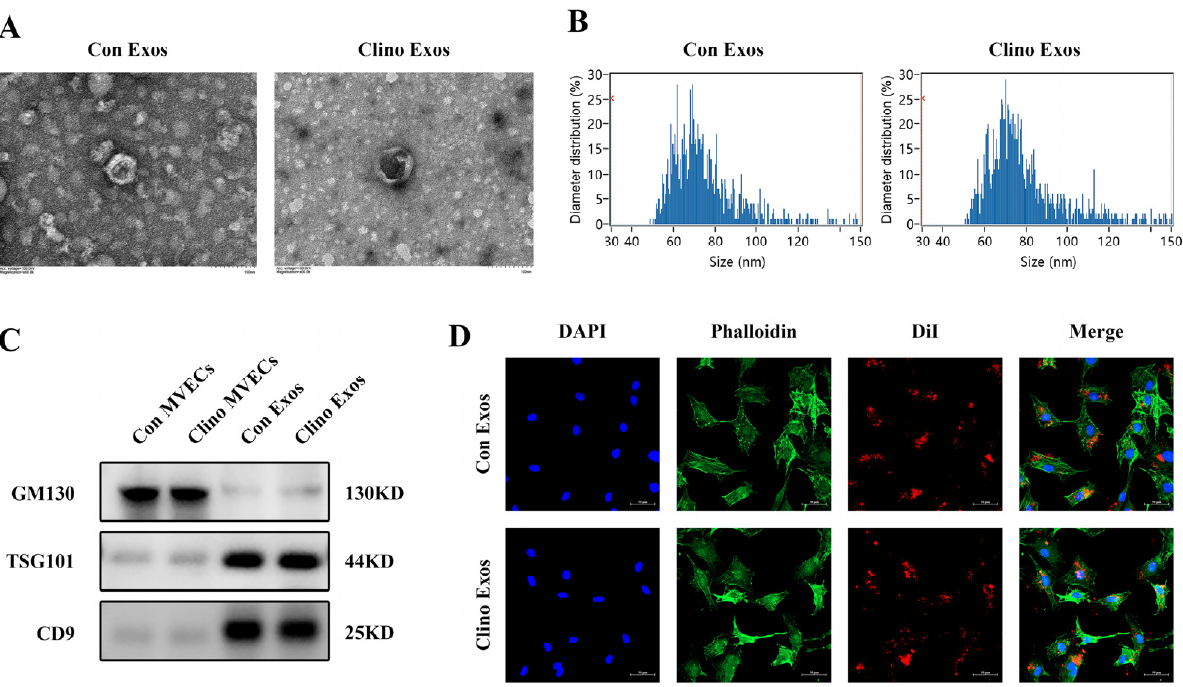
Figure 1. Isolation, identification, and internalization of MVEC-derived exosomes. ( A ) TEM demonstrated the typical characteristics of exosomes generated from MVECs (scale bar, 100 nm). ( B ) Flow NanoAnalyzer analyzed the size distribution of exosomes. ( C ) Exosomal/cellular protein markers in donor cells and extracted exosomes detected by Western blotting analysis. ( D ) Confocal microscopy images displaying the absorption of exosomes secreted from MVECs by MC3T3-E1 cells. DiI-labeled MVEC-derived exosomes are red, and DAPI (blue) and phalloidin (green) labeled the cells (scale bar, 50 µ